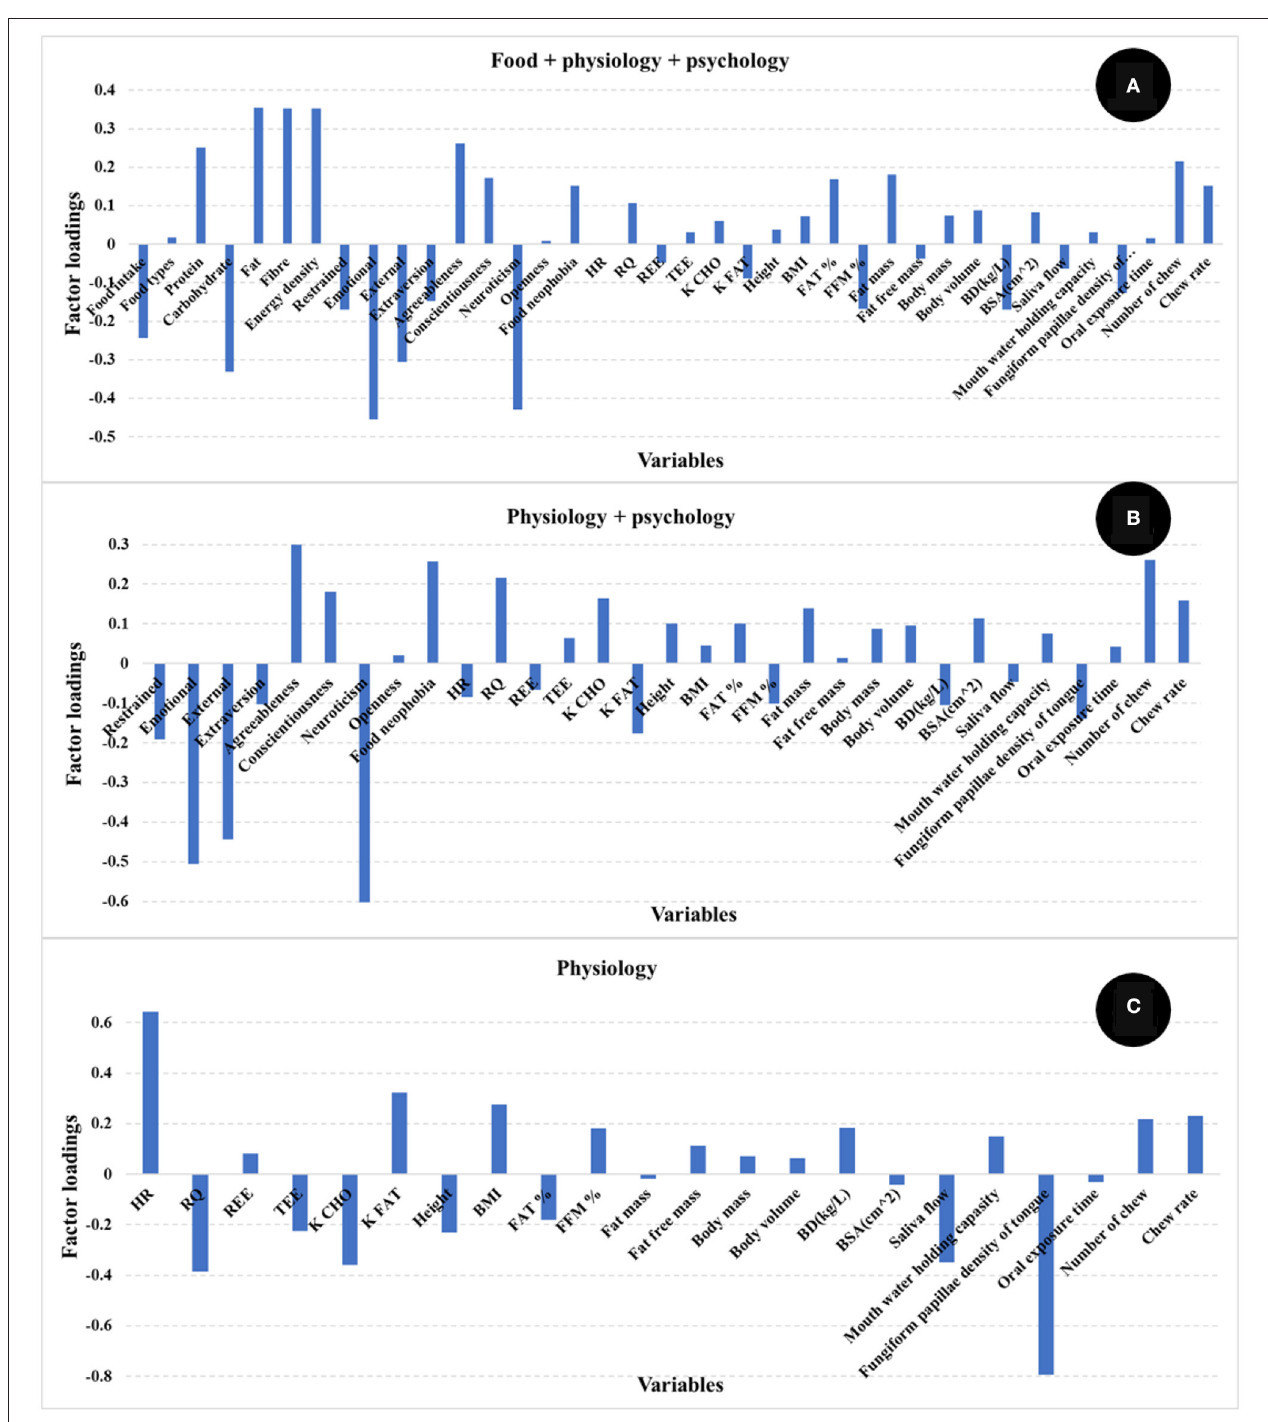
FIGURE 3 | Loadings for PLS regression models comparing the different independent variables [ (A) food + physiology + psychology, (B) physiology + psychology, (C) only physiology]. The factor loadings indicate the variables’ contribution to satiety.